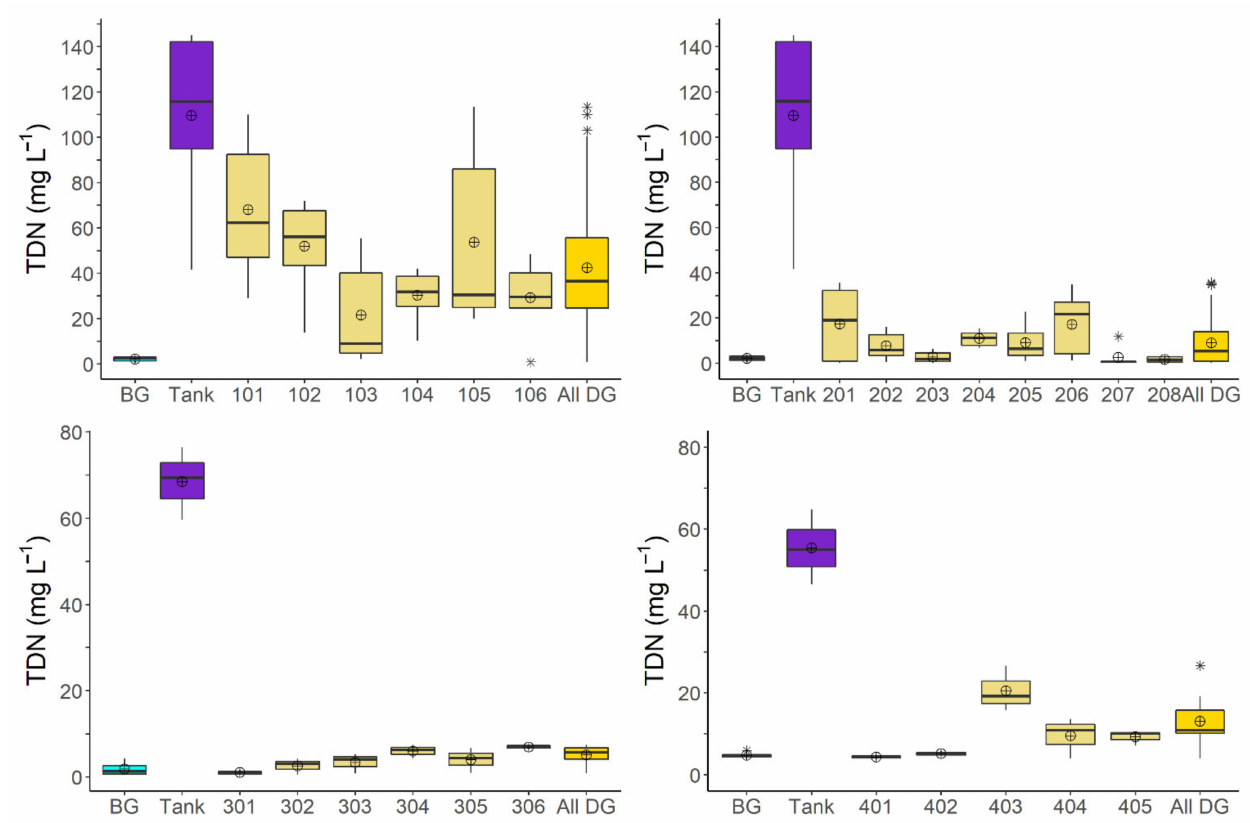
Figure 3. Box plots showing total dissolved nitrogen (TDN) concentrations in background groundwater (BG), septic tank effluent (tank), in groundwater from individual wells, and pooled data from groundwater near and down-gradient from the systems (DG). Wells BG, 301, 302, 401 and 402 serve as background groundwater sampling locations for the sites. Wells 404 and 405 are located 15-m down-gradient from the Site 400 drainfield. Other wells (101–106, 201–208, 303–306, 403) are between drainfield trenches or <3 m down-gradient from the drainfields and are considered drainfield wells. Circles indicate mean concentrations, horizontal lines show median concentrations, asterisks are statistical